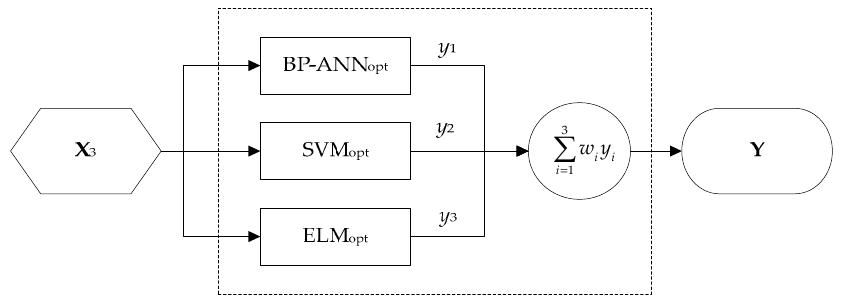
Figure 3. The flowchart of fusion models developing and testing.